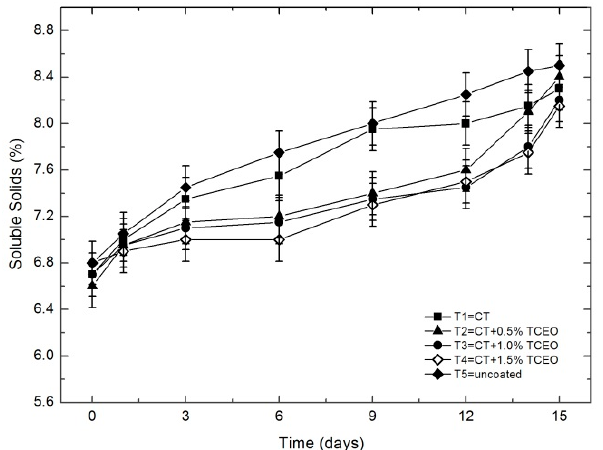
Figure 3. Evolution of the total soluble solids content by TSS measurement in strawberries with chitosan (CT) and treatments of oil (TCEO): T1 = CT, T2 = CT + 0.5% of TCEO, T3 = CT + 1.0% of TCEO, T4 = CT + 1.5% TCEO, and T5 = uncoated. Mean values and intervals of Fisher’s LSD of 95% according to the ANOVA test.